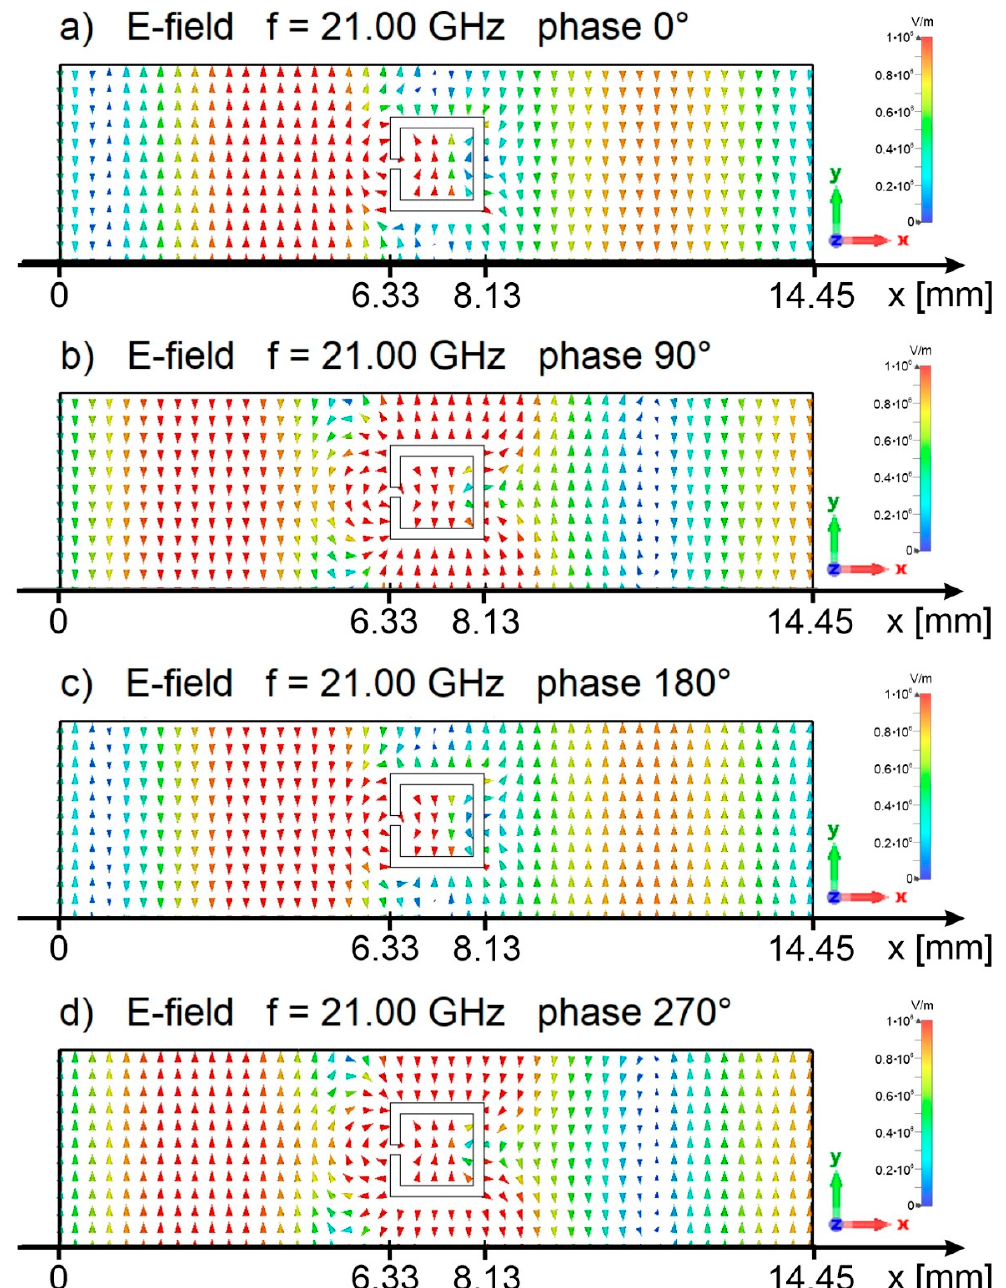
Figure 8. Distribution of the electric field E in the cross-sections xy for z = − 1.6 mm at f = 21 GHz corresponding to the detune magnetic resonance. The plane electromagnetic wave propagates in the +x axis: ( a ) Phase 0°; ( b ) phase 90°; ( c ) phase 180°; ( d ) phase 270°. The wave incident on the SRR structure results in partial reflection (19%) and transmission (81%).